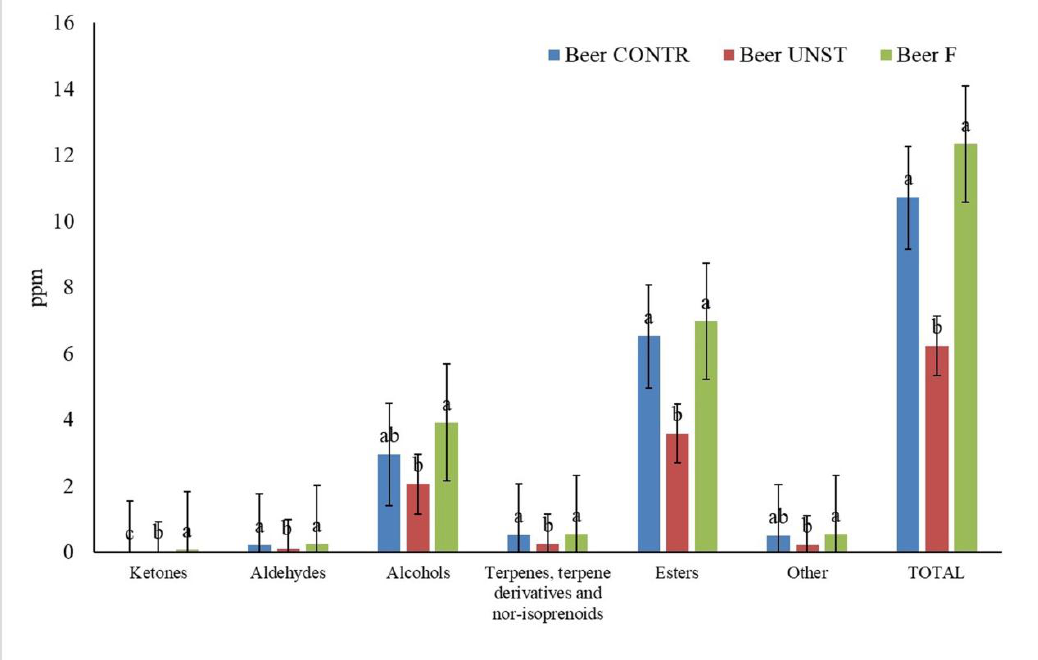
Figure 3. Effect of unstarted and fermented apple pomace addition on volatile composition of beer after 30 days of maturation. One-way ANOVA, Tukey’s test ( p ≤ 0.05). Beer CONTR: Beer with no added apple pomace ( ); Beer UNST: beer with added unstarted apple pomace ( ); Beer F: beer with added Lactobacillus rhamnosus 1473 fermented heated apple pomace ( ).